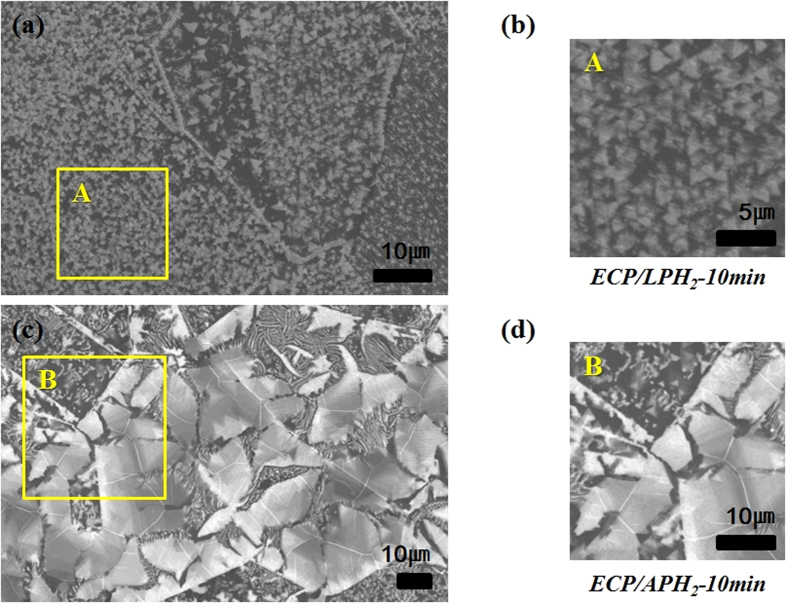
The comparison of SEM images of the Ni foil with ECP/LPH2-10 min (a,b) and ECP/APH2-10 min (c,d).